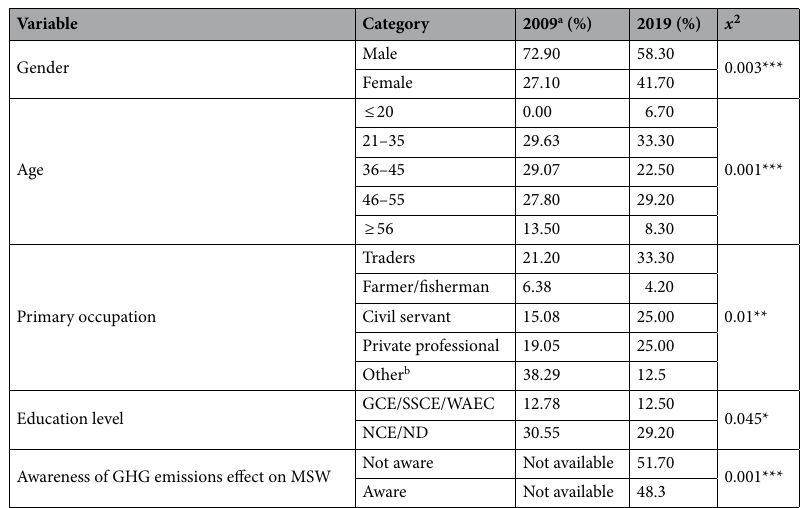
Table 1. Survey variable results for Benin City. GCE General Certificate of Education, SSCE Senior Secondary Certificate Examination, WAEC West African Examination Council, NCE National Certificate of Education, ND National Diploma. a Data sourced from Ekhaese et al. 35 ; significance level of each variable: * p = 0.1,